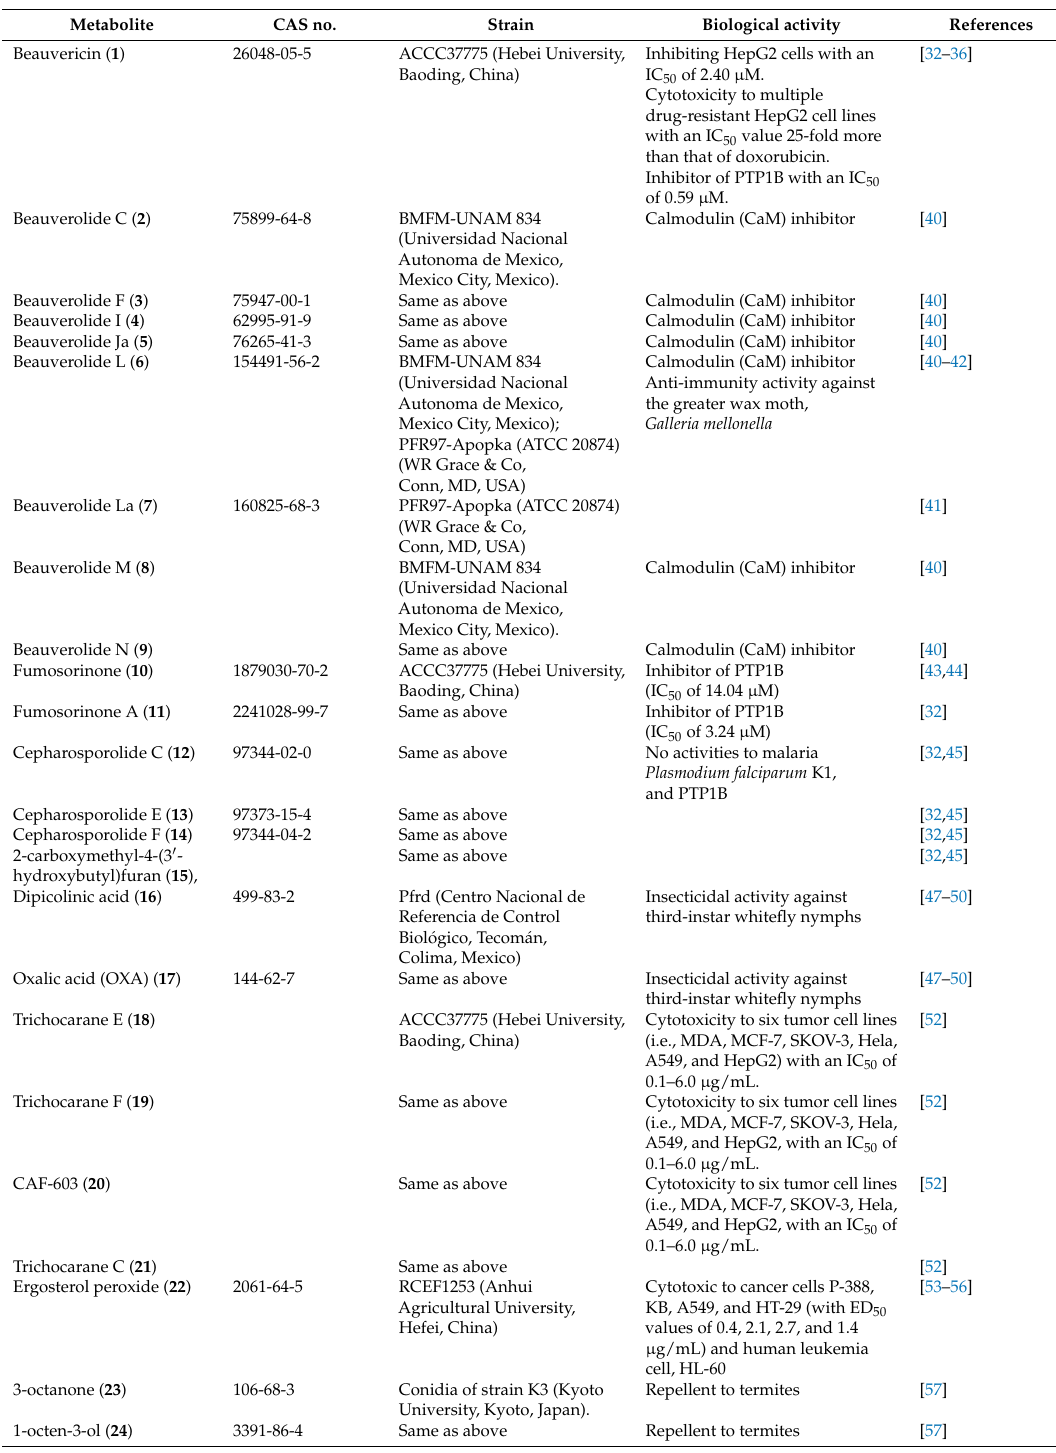
Table 1. SMs from Isaria fumosorosea and their biological